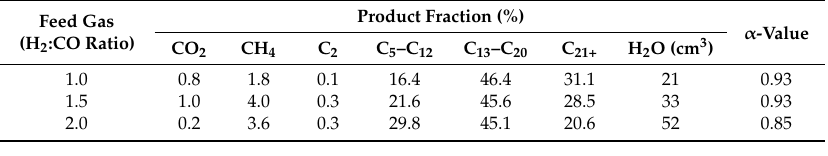
Table 3. Product fractions with various feed gas compositions at 24 h of FTS reaction tested at 220 ◦ C, 2 MPa and GHSV of 3600 cm 3 · g − 1 · h − 1 .